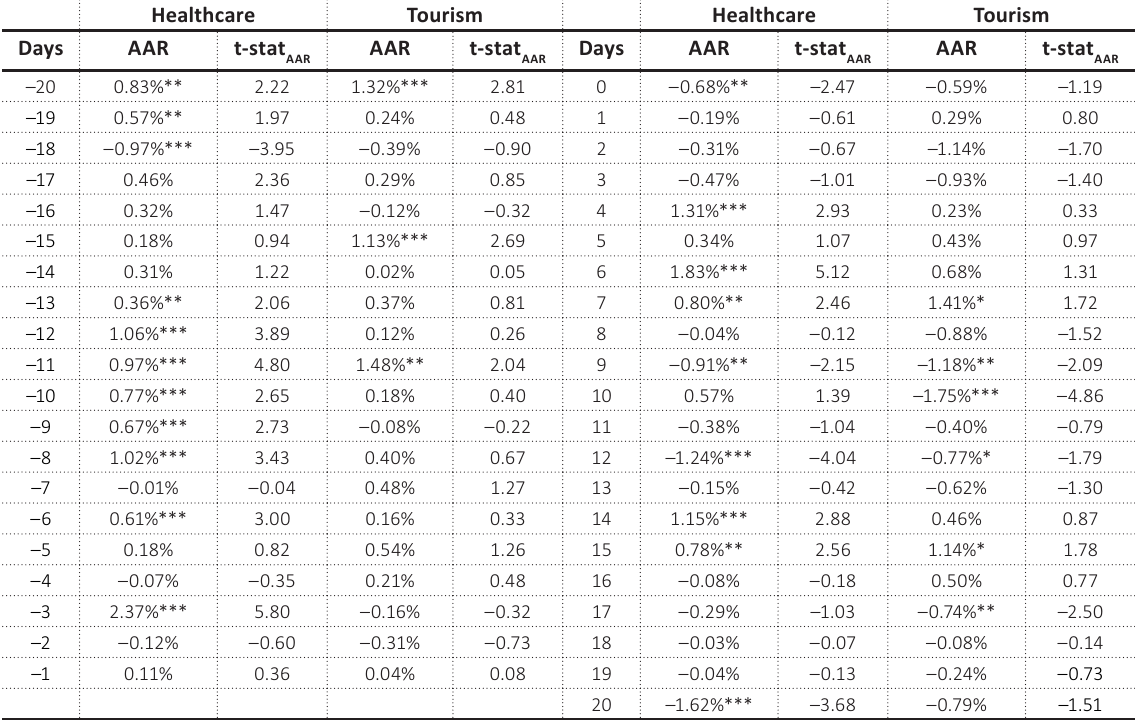
Table 1. Abnormal returns and t-statistics of healthcare and tourism sectors surrounding the first reported COVID-19 case (e1) Healthcare Tourism Healthcare